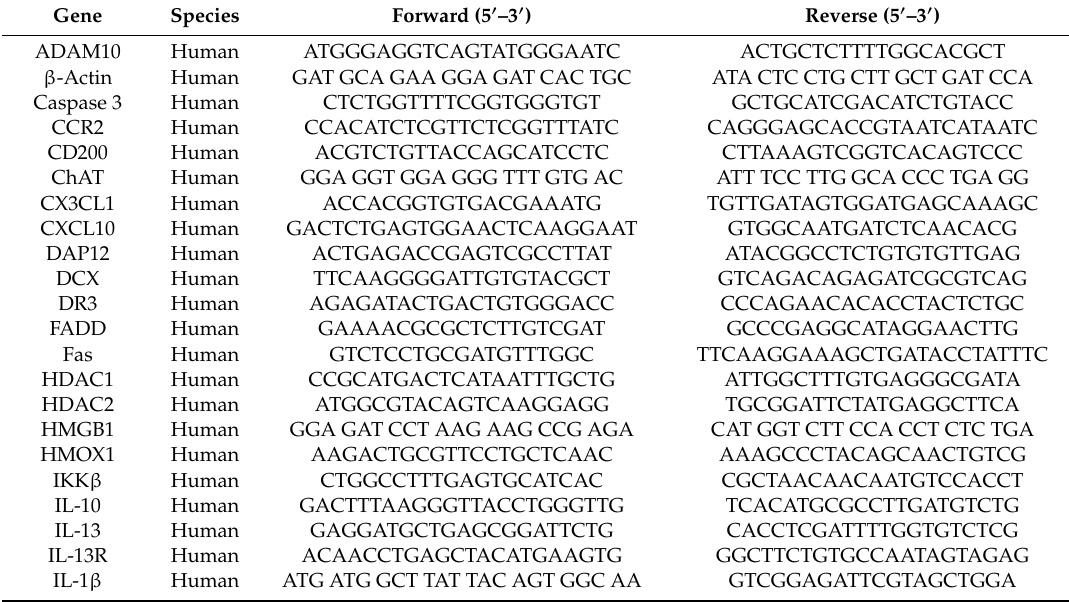
Table 1. Primers used for real-time polymerase chain